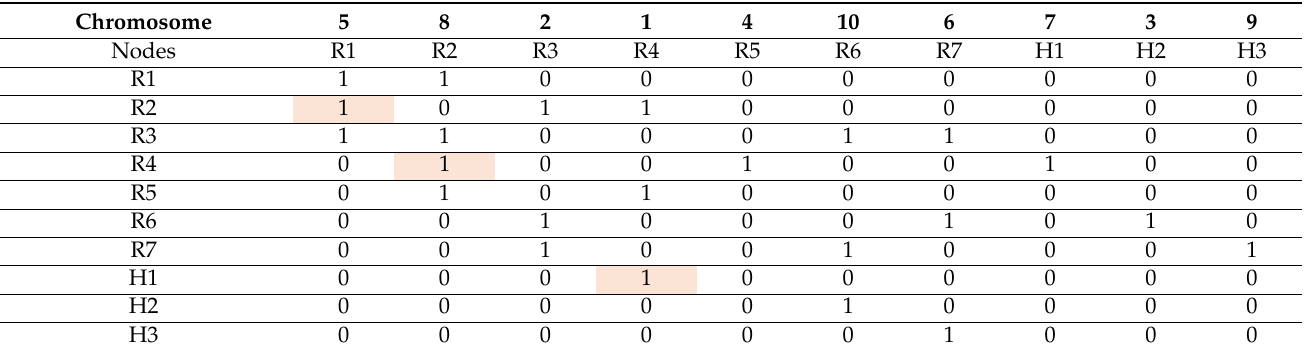
Table 3. Example topology adjacencies matrix for coding representation. The path source: H1 and destination: R1. The hops of H1-R1 are highlighted.